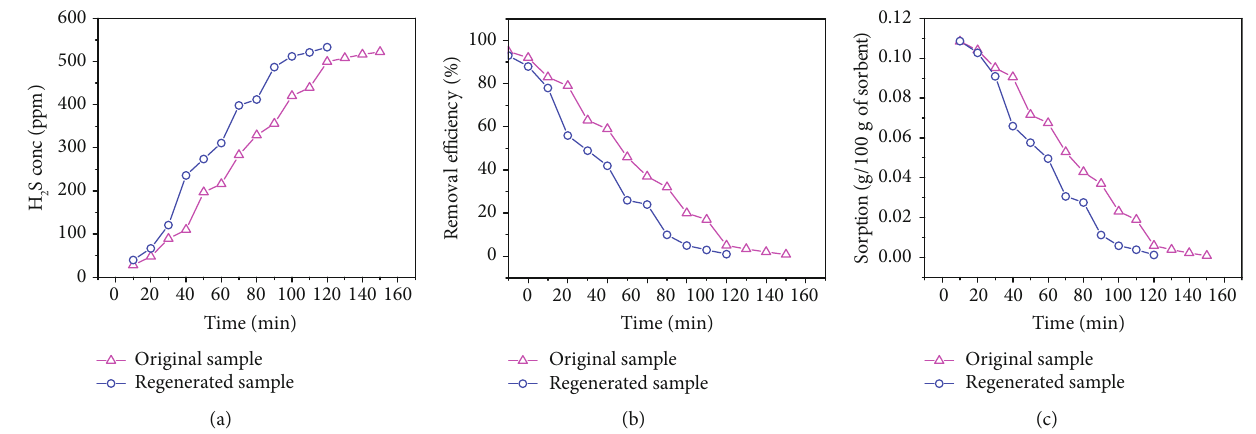
S outlet concentration after fi lter. (b) RE. (c) 2 = 539 ppm . o